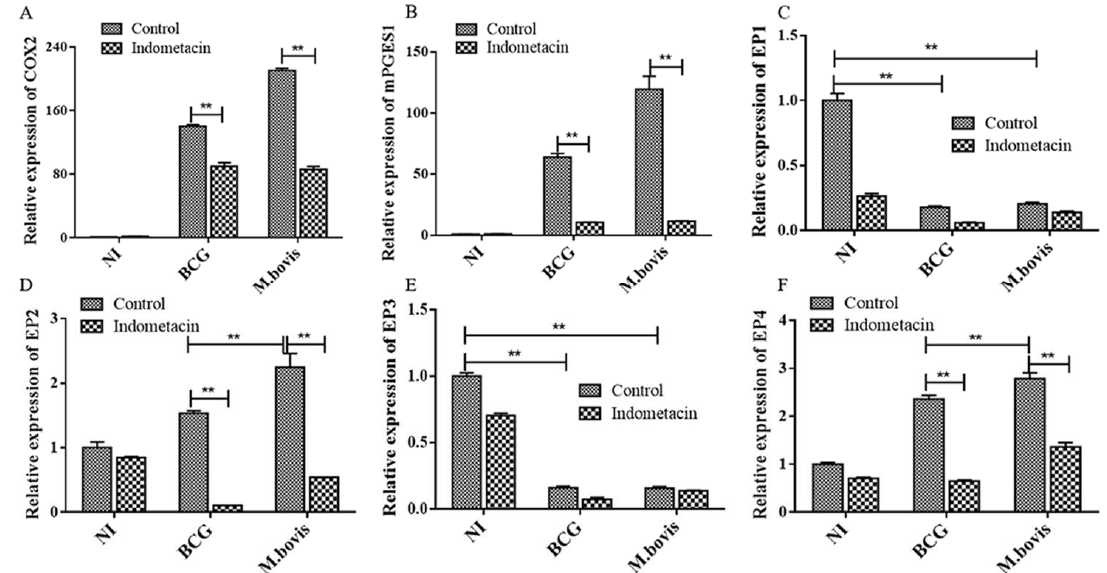
Figure 3. The effect of the COX inhibitor indomethacin on the expression of COX-2, mPGES1, and PGE2 receptors. DCs were infected with M. bovis and BCG at an MOI of 10. The mRNA expression of COX2 ( A ), mPGES1 ( B ), and E-prostanoid (EP)1-4 ( C – F ) in different DC groups with or without 50 mg/mL indomethacin treatment. The data shown are the mean ± SD of three replicates, where * represents p < 0.05 and ** represents p < 0.01.